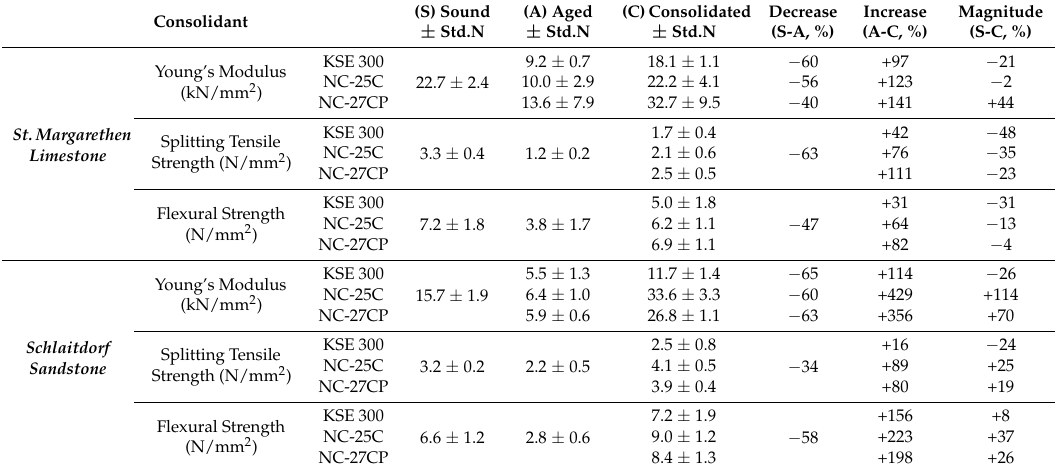
Table 3. Rounded values for relative decrease/increase [%] for sound (S), aged (A) and consolidated (C) samples and absolute average values of Young’s modulus [kN/mm 2 ], splitting tensile strength [N/mm 2 ], and flexural strength under concentrated load [N/mm 2 ] for St. Margarethen Limestone and Schlaitdorf Sandstone . The graphical visualisation of the same values can be found in Figure 6. All tests were performed six months after consolidation. (S) Sound (A) Aged (C)Consolidated Decrease Increase Magnitude Consolidant ± Std.N ± Std.N ± Std.N (S-A, %) (A-C, %) (S-C,